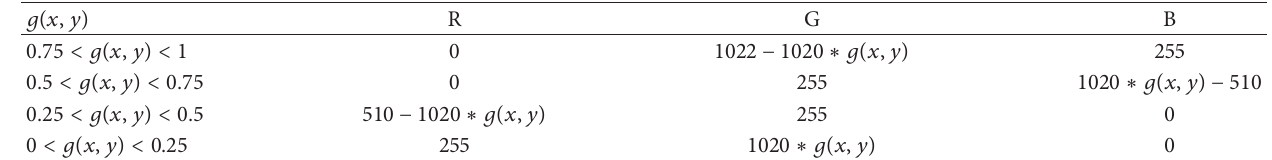
Table 1: RGB color mapping for the pixel ( 𝑥,𝑦 ) based on the mapping index 𝑔(𝑥,𝑦) .